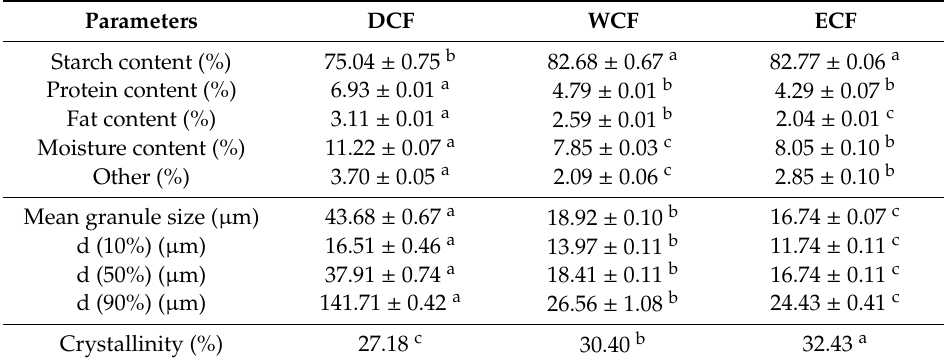
Table 1. The chemical composition analysis, size distribution and crystallinity of corn flours.